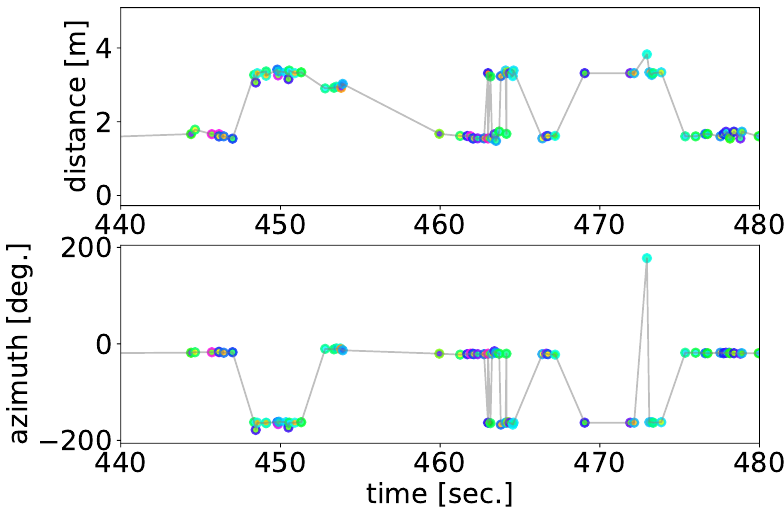
Figure 10. Detailed results of that shown in Figure 8 during 440–480 s. Multiple individuals sang alternately at approximately − 10 ◦ and − 180 ◦ . The dot colors correspond to the colors given in Figure 7.